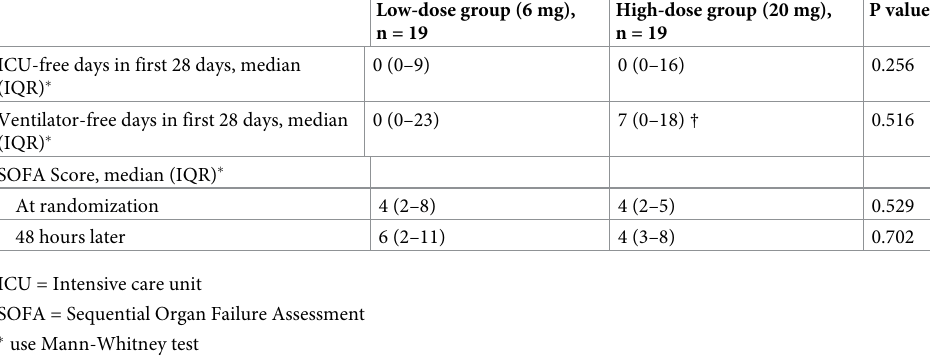
Table 4. Outcomes for participants who required ICU care within 28 days (n =